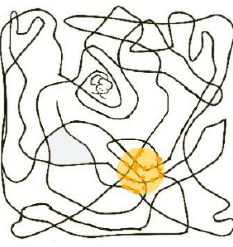
Figure 1. Certain cells are active at a particular position.